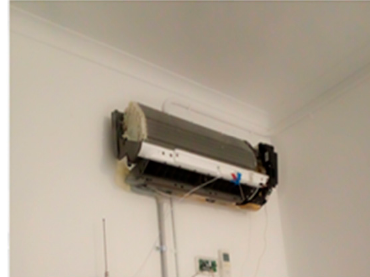
Figure 9. Air-conditioner.